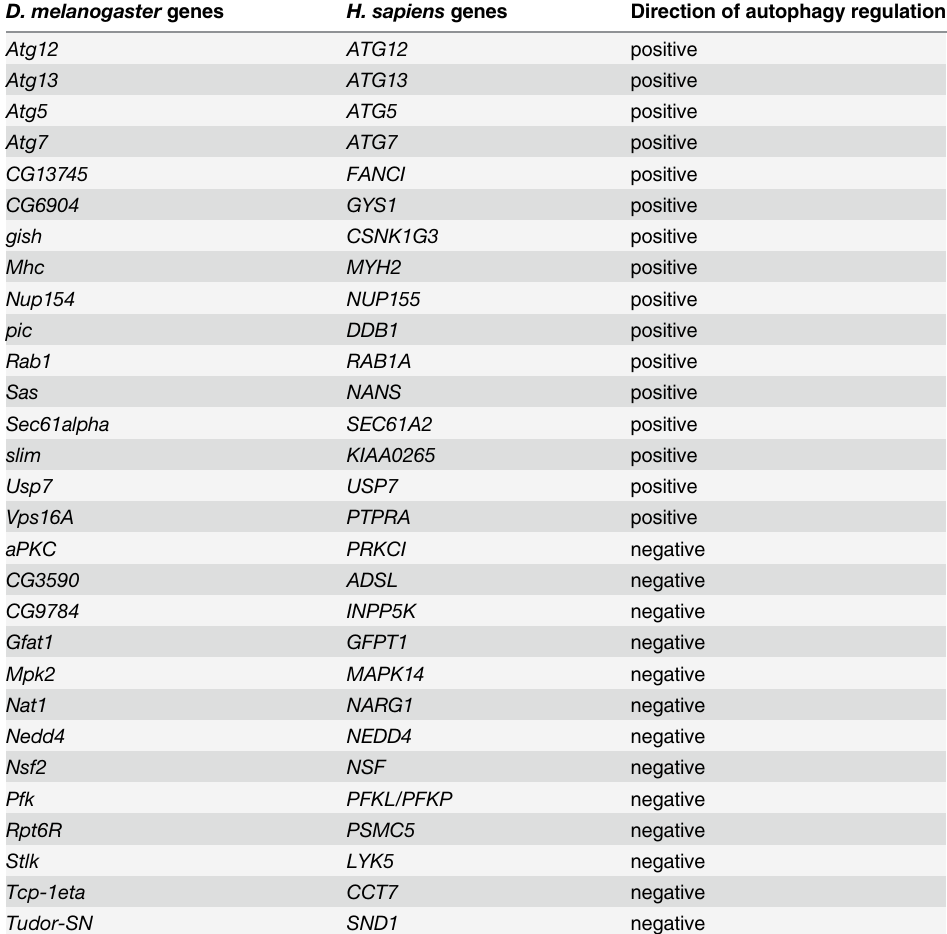
Table 2. List of genes with one dsRNA scoring in primary culture screen. D. melanogaster